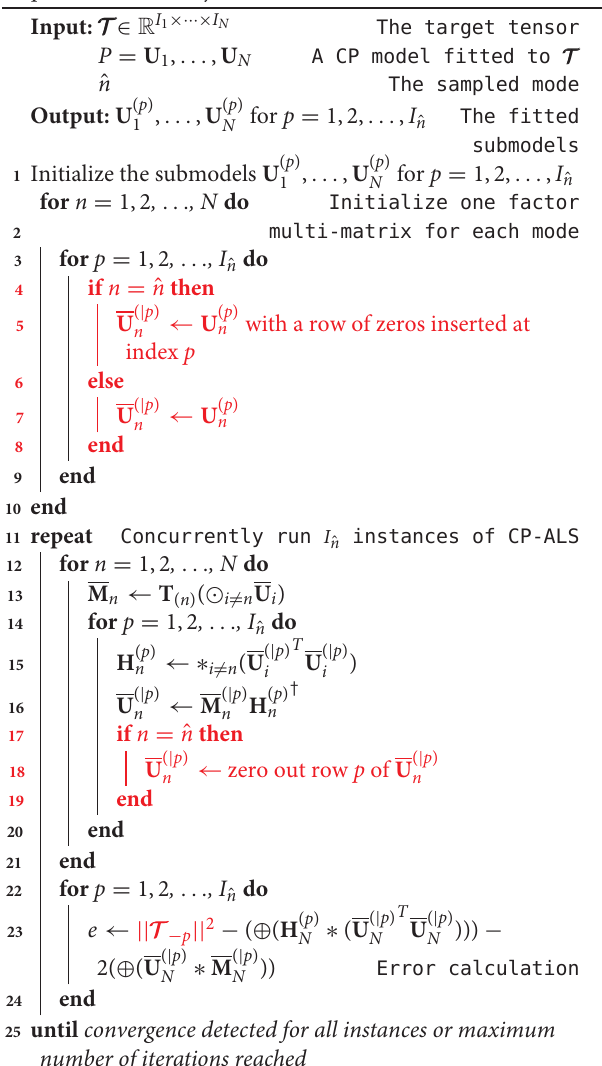
Algorithm 3: JK-CALS: Concurrent alternating least squares method for jackknife